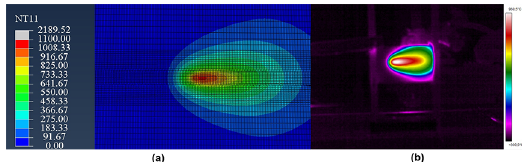
Figure 10. Photography of temperature fields after a distance of 66mm covered by the welding torch, where a) FEM and b) IR. Both pictures represent the welding torch moving from the right to the left direction of the paper similar heating cycles and peak temperatures. Whereas for the cooling cycles up to a temperature of 300 C the curves behave similarly but after about 300 C, there is a marked discrepancy between the experimental and numerical results.